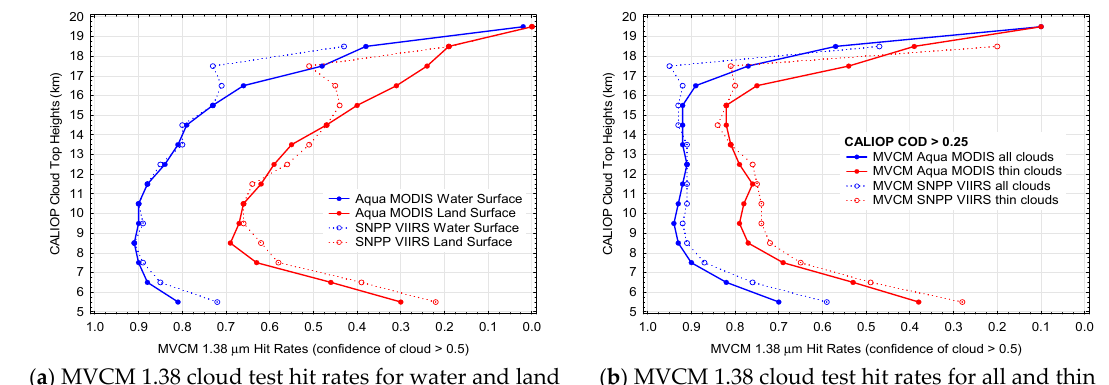
Figure 4. MVCM 1.38 µm cloud tests vs. CALIOP cloud detection by cloud height; ( a ) hit rates over water (blue) and land (red) for MVCM Aqua MODIS (solid lines) and MVCM SNPP VIIRS (dotted lines); ( b ) hit rates for all clouds (blue) and thin clouds (red) where CALIOP cloud optical depth > 0.25 for MVCM Aqua MODIS (solid lines) and MVCM SNPP VIIRS (dotted lines).